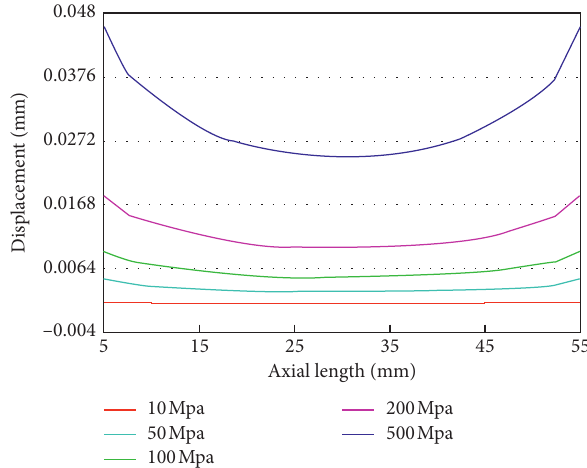
Figure 8: Comparison of contact displacements under different loads.